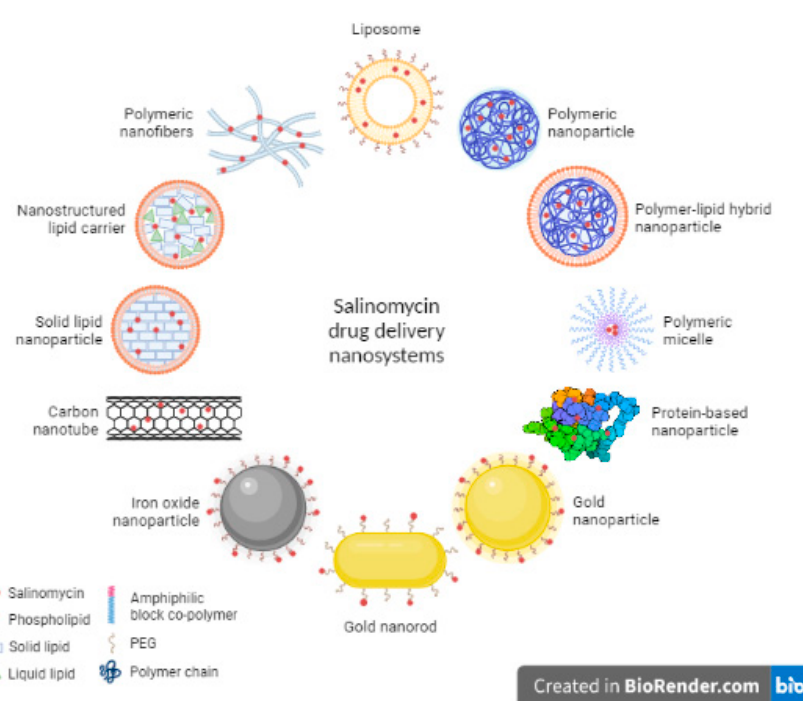
Figure 3. Drug delivery systems for salinomycin (Figure created with BioRender.com [accessed on 25 June 2021]).